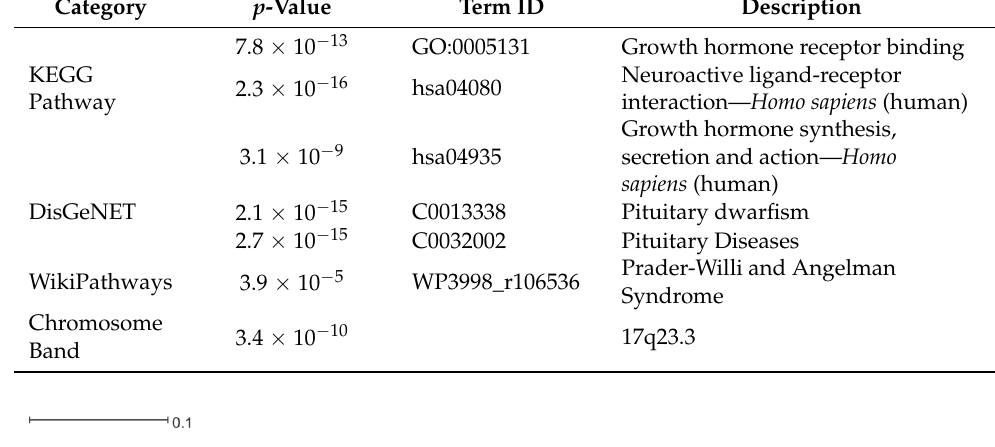
Table 13. Selected top gene term enrichments of the coexpressed genes to CSHL1 in HGCA2.0.